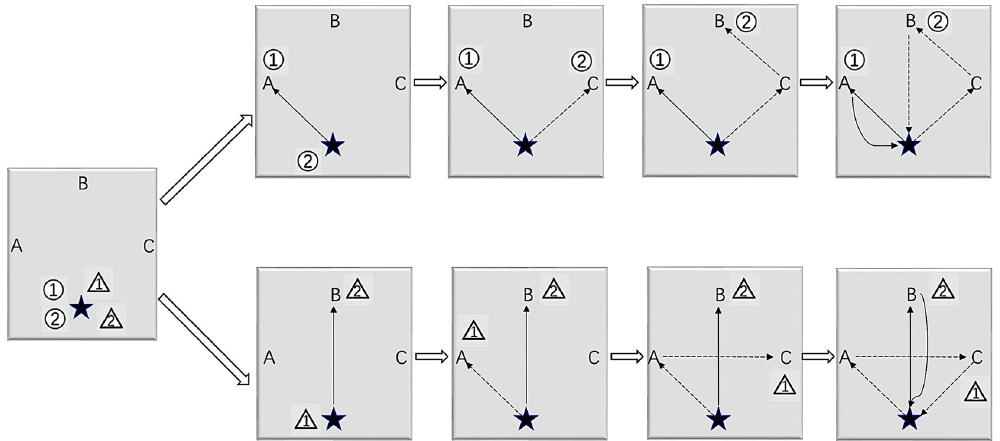
Fig 1. An illustrative example of parallel route